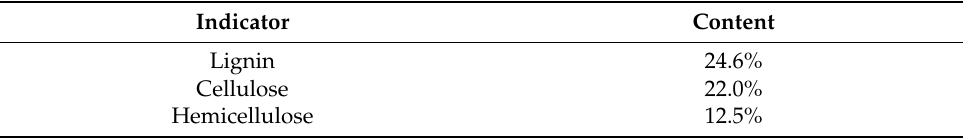
Table 1. Dry matter composition of materials.